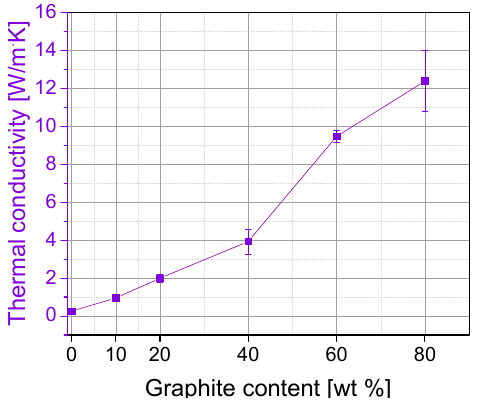
Figure 2. Thermal conductivity of PP/graphite composites.